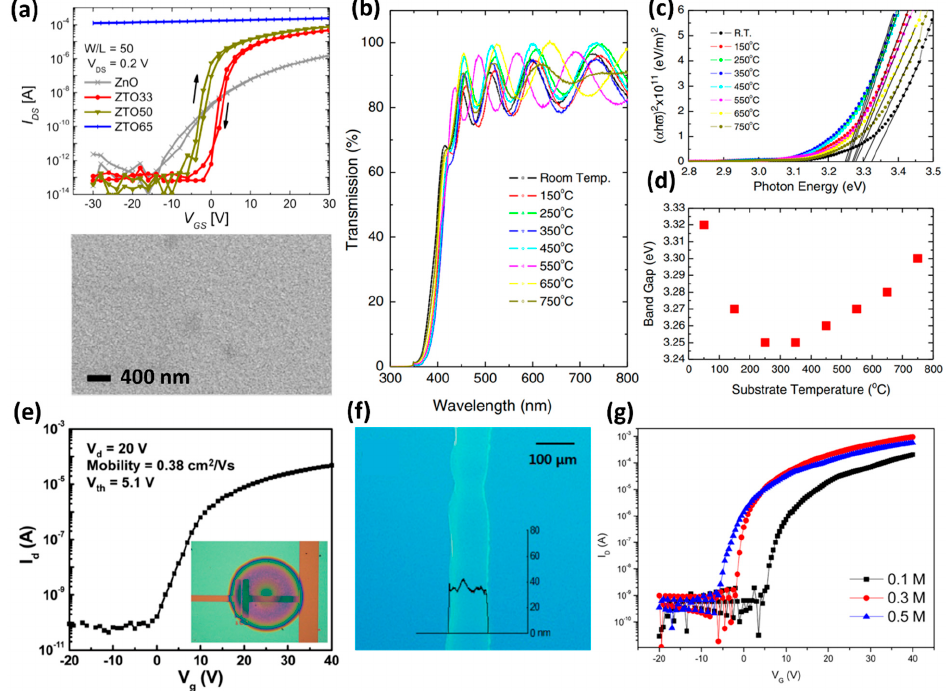
Figure 1. ( a ) Transfer characteristics of the ZTO TFT depending on the adjusted tin ratio. The TFT was measured as V DS = 0.2 V, and plan view scanning electron microscopy (SEM) image of ZTO films (adapted from [40] with permission from John Wiley and Sons). ( b ) Transmittance of the fabricated ZTO film, and ( c ) relationship between ( ahv ) 2 and hv depending on the substrate temperature. ( d ) The optical band gap of ZTO film according to the substrate temperature (adapted from [2] with permission from Elsevier). ( e ) Transfer characteristics of the inkjet-printed transistors (adapted from [48] with permission from American Chemical Society). ( f ) Optical microscopy image of the patterned ZTO by EHD-jet. ( g ) Transfer characteristics of the EHD-jet printed ZTO TFT with different mole ratios (adapted from [49] with permission from the American Chemical